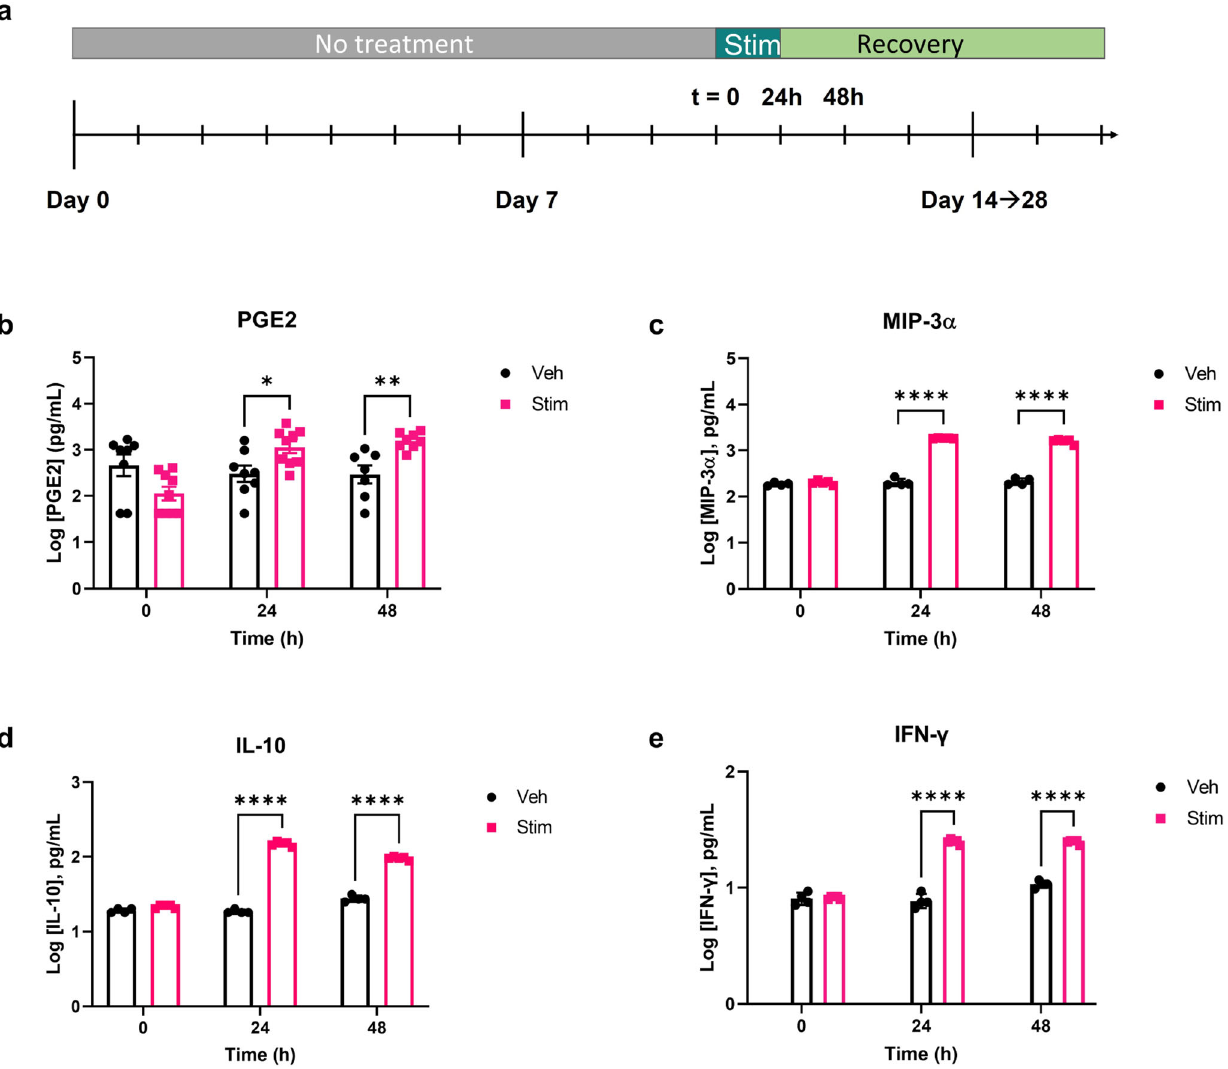
Fig. 2 MOUTH tissue responded to a single dose of in fl ammatory stimuli. a MOUTH samples were stimulated with an in fl ammatory trigger of 300 ng/ mL each of TNF- α and IL-1 β (Stim) around day 10 of culture and evaluated compared to vehicle controls. b Secreted levels of PGE2 increased in bottom channels of MOUTH Stim devices compared to vehicle control devices within 24 h ( p < 0.0332) and remained higher than vehicle controls for at least 48 h ( p < 0.0021). Data from b are averaged across three experiments ( N = 3 – 12 per experiment). c – e Devices stimulated with in fl ammatory cytokines IL- 1 β + TNF- α produced an increase in MIP-3 α , IL-10, and IFN- γ production at 24 and 48 h following stimulation. Data from c – e are from one experiment with N